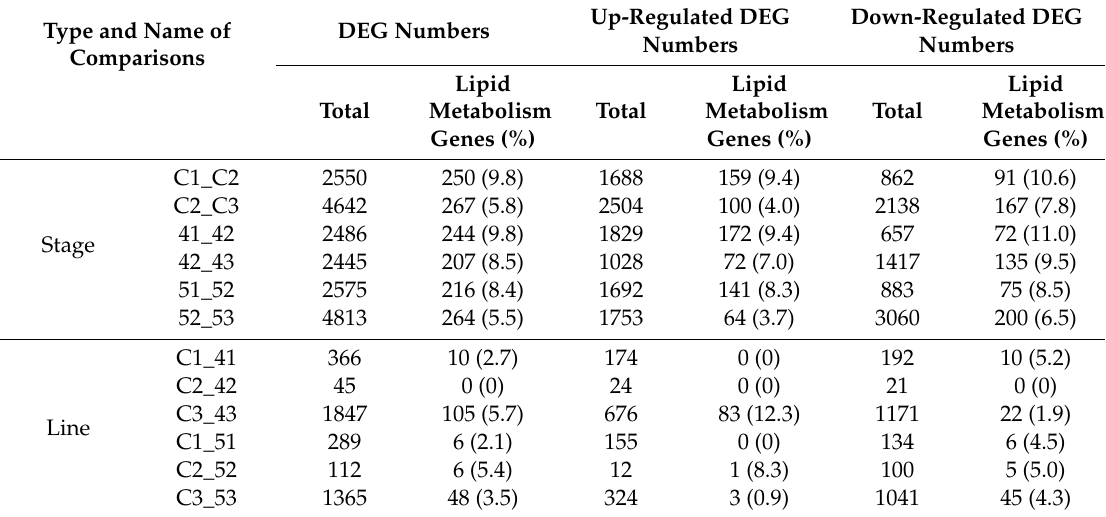
Table 2. Summary of DEG numbers in total transcriptome and lipid metabolism. In each comparison, the names of the two RNA samples compared are included in the comparison name, separated by an underscore. The percentages of lipid metabolism DEGs in the total DEGs are shown in the